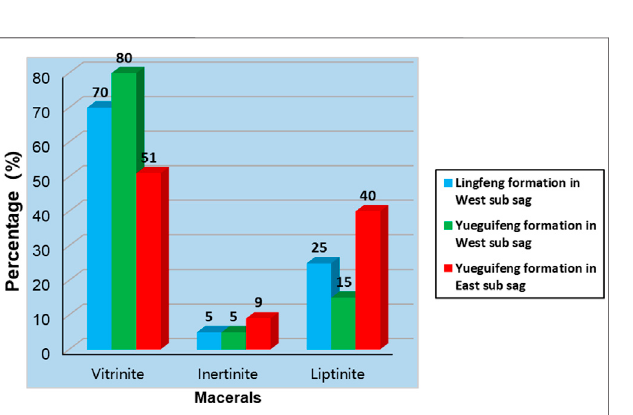
FIGURE 6 | Maceral composition of selected samples in the Lishui Sag.